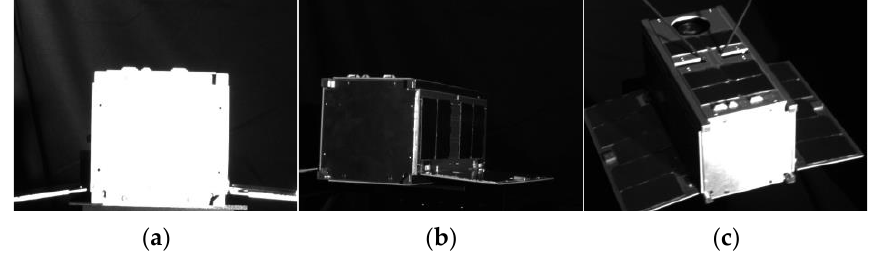
Figure 10. Some images in the MNS-LS dataset. ( a ) High-brightness image. ( b ) Low-brightness image. ( c ) An image with noise.